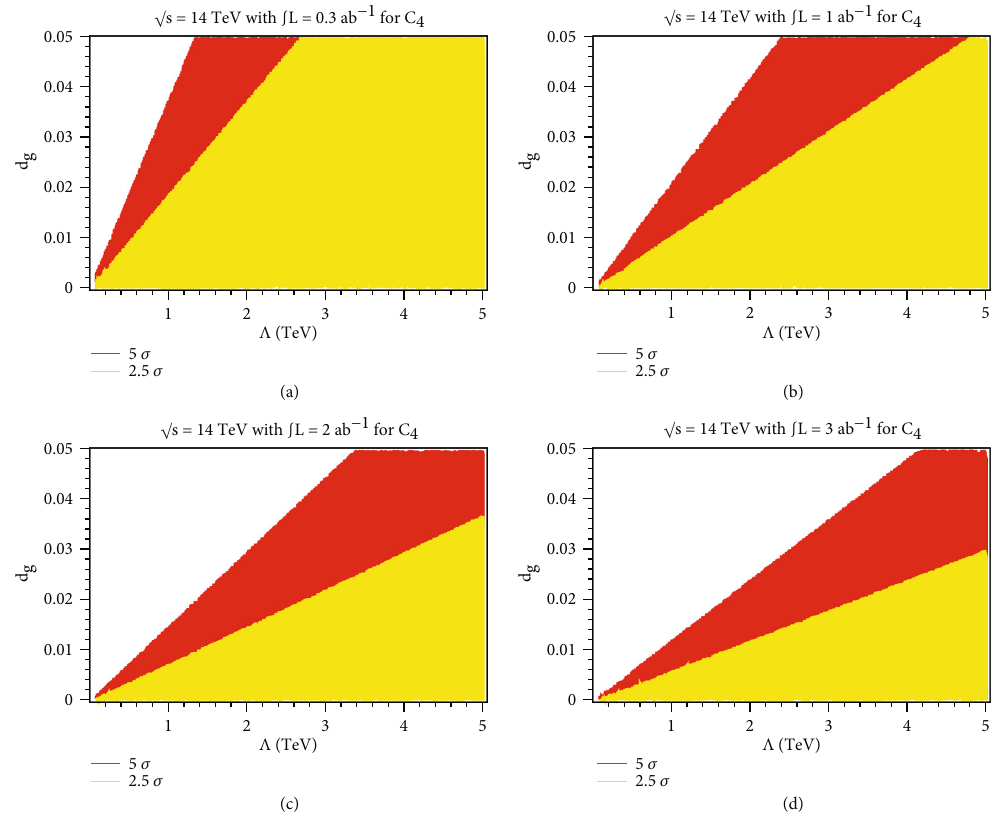
ffiffiffi p at = 14TeV energy at LHC for an integrated luminosity of (a) 0 : 3 ab − 1 , (b) 1 ab − 1 , (c) 2 ab − 1 , and (d) S 4